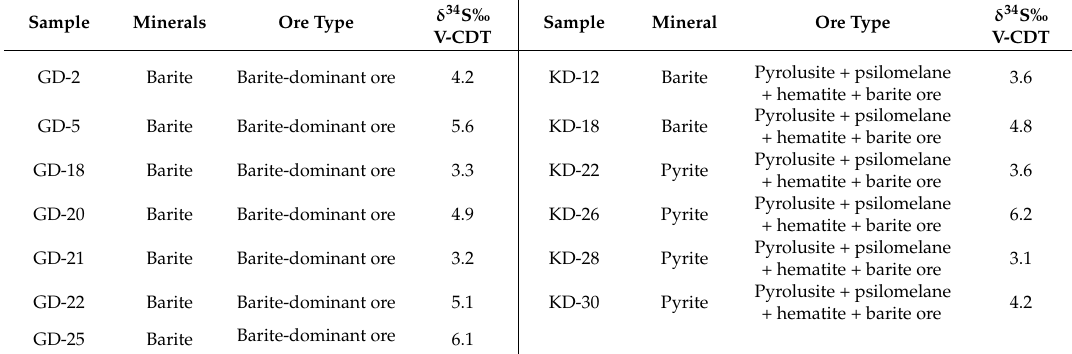
Table 5. Sulphur isotopic data on Tumanpınarı